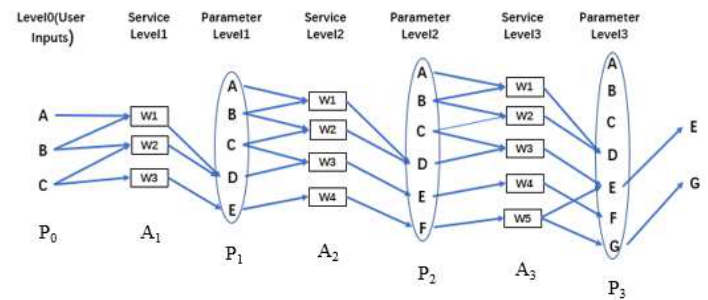
Figure 3. Example of the service planning graph